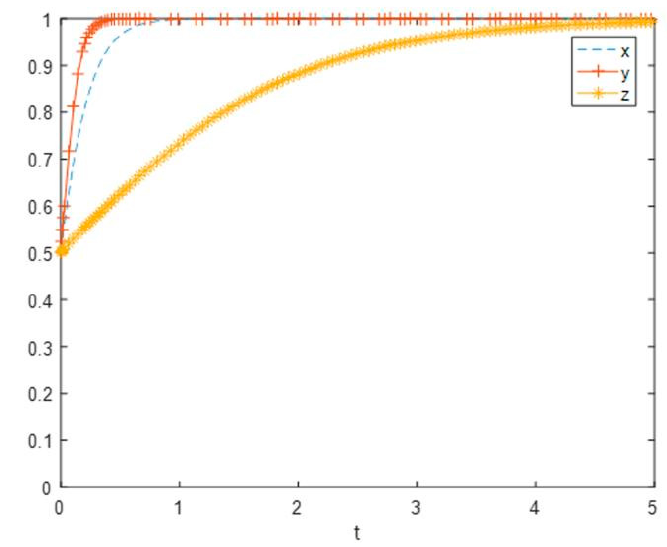
Figure 11. Two-dimensional diagram of evolutionary path at stable point (1, 1, 1).